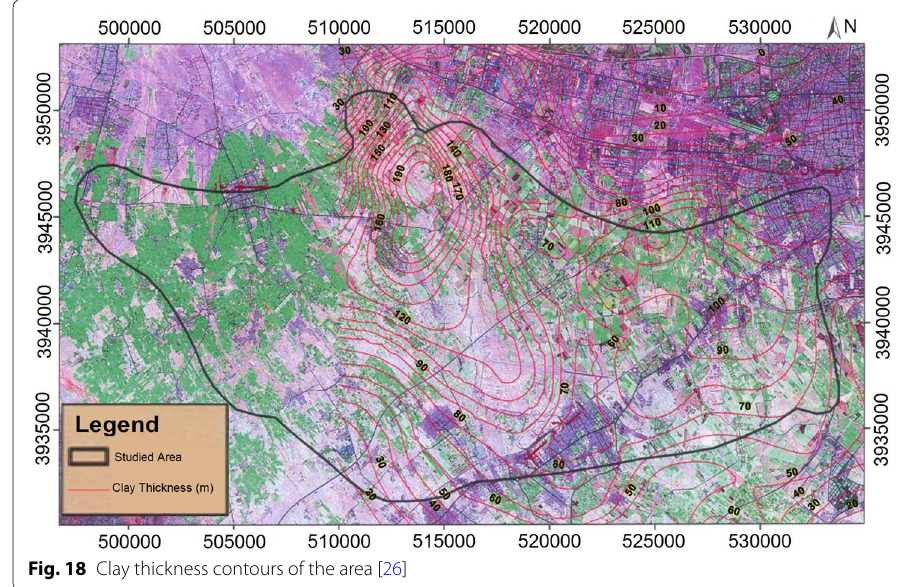
Fig. 18 Clay thickness contours of the area [26]